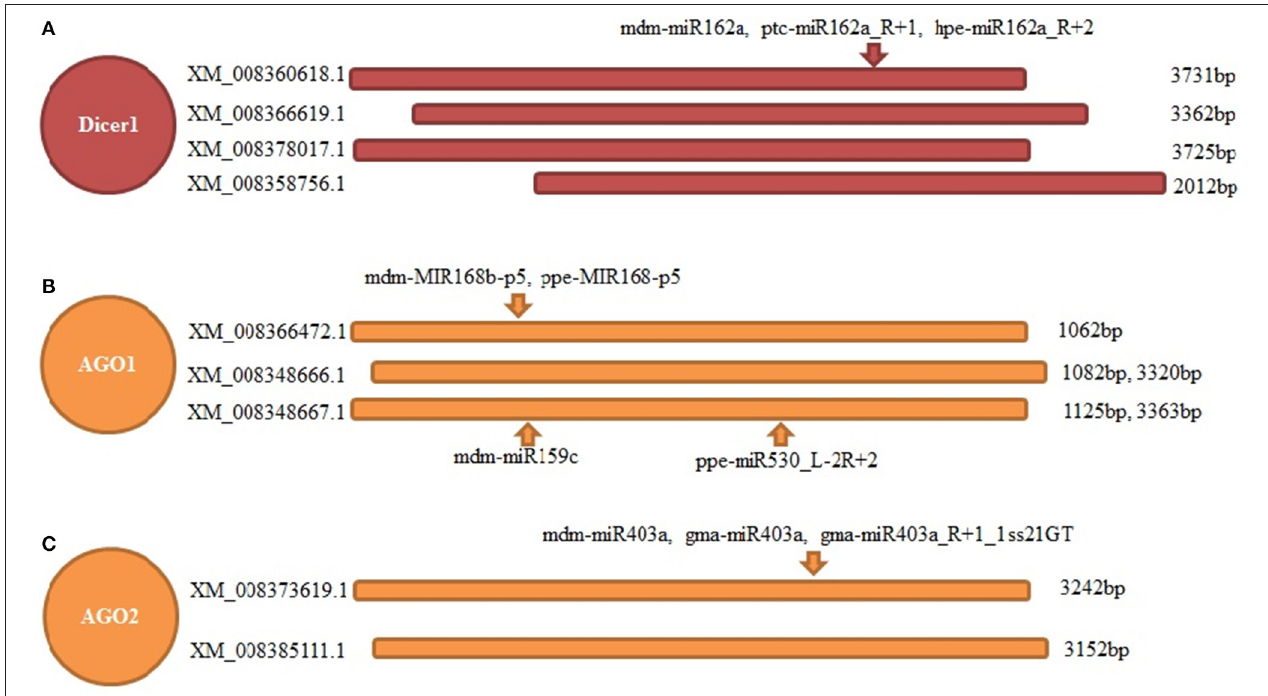
FIGURE 7 | Feedback regulation of main components of RNAi pathway in apple twig bark— V. mali interaction. Three main components of RNAi pathway were found to be feedback regulated by several miRNAs. (A) Four transcripts of Dicer1 were detected to be cleaved at one common site by three miRNAs from the same family. (B) Three transcripts of AGO1 were detected to be cleaved at distinct sites by four miRNAs from three families. (C) Two transcripts of AGO2 were detected to be cleaved at one common site by three miRNAs from same